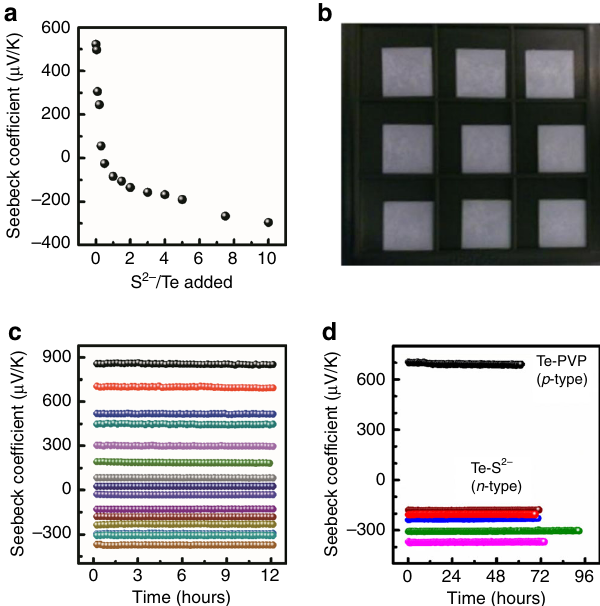
Fig. 4 Tuning Seebeck coef fi cients with controlled doping. a Seebeck coef fi cient from a series of doped Te NW samples versus the amount of S 2 − added to the exchange solution, normalized to the total number of Te atoms present on the surface of the NW. b Representative set of smooth drop-cast fi lms used for the measurements. c Short-term stability tests from a series of Te NW samples with varying doping concentrations. d Long-term stability tests for as-synthesized p -type Te NWs capped with polyvinylpyrrolidone (black) and multiple batches of fully surface exchanged Te NWs with S 2 − (colors). The data in green is from a sample stored in ambient for nearly 7 months and the data in red is from a device stored in the glove box for 23